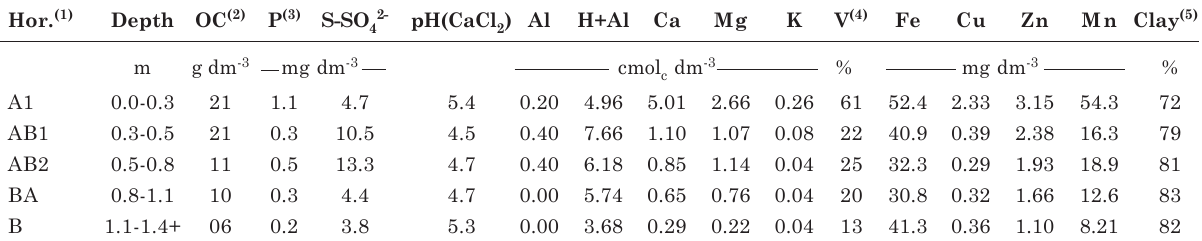
(1) Pedological horizon; (2) OC: Organic carbon; (3) P extracted by Mehlich-1 (Pavan et al., 1992); (4) V: base saturation; (5) Clay content (Embrapa, 1997).